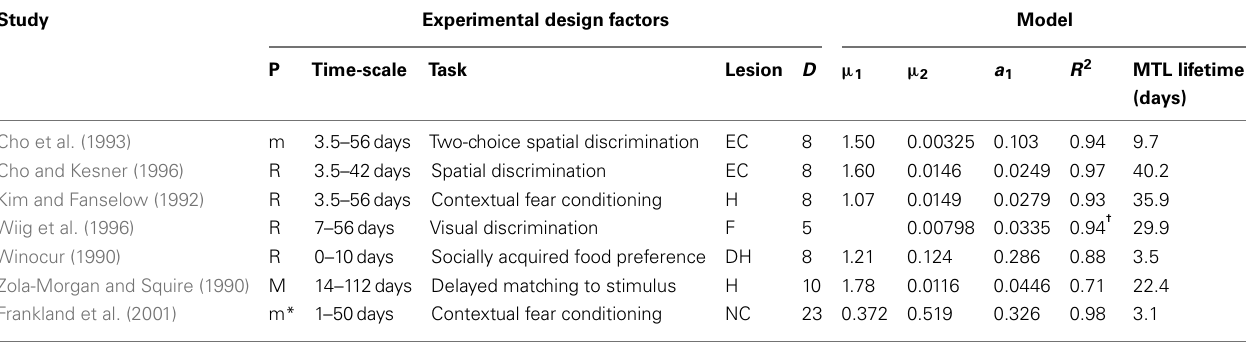
Table 2 | Fits to experiments with mice, monkeys, and rats with lesions or transgenic alterations in the indicated